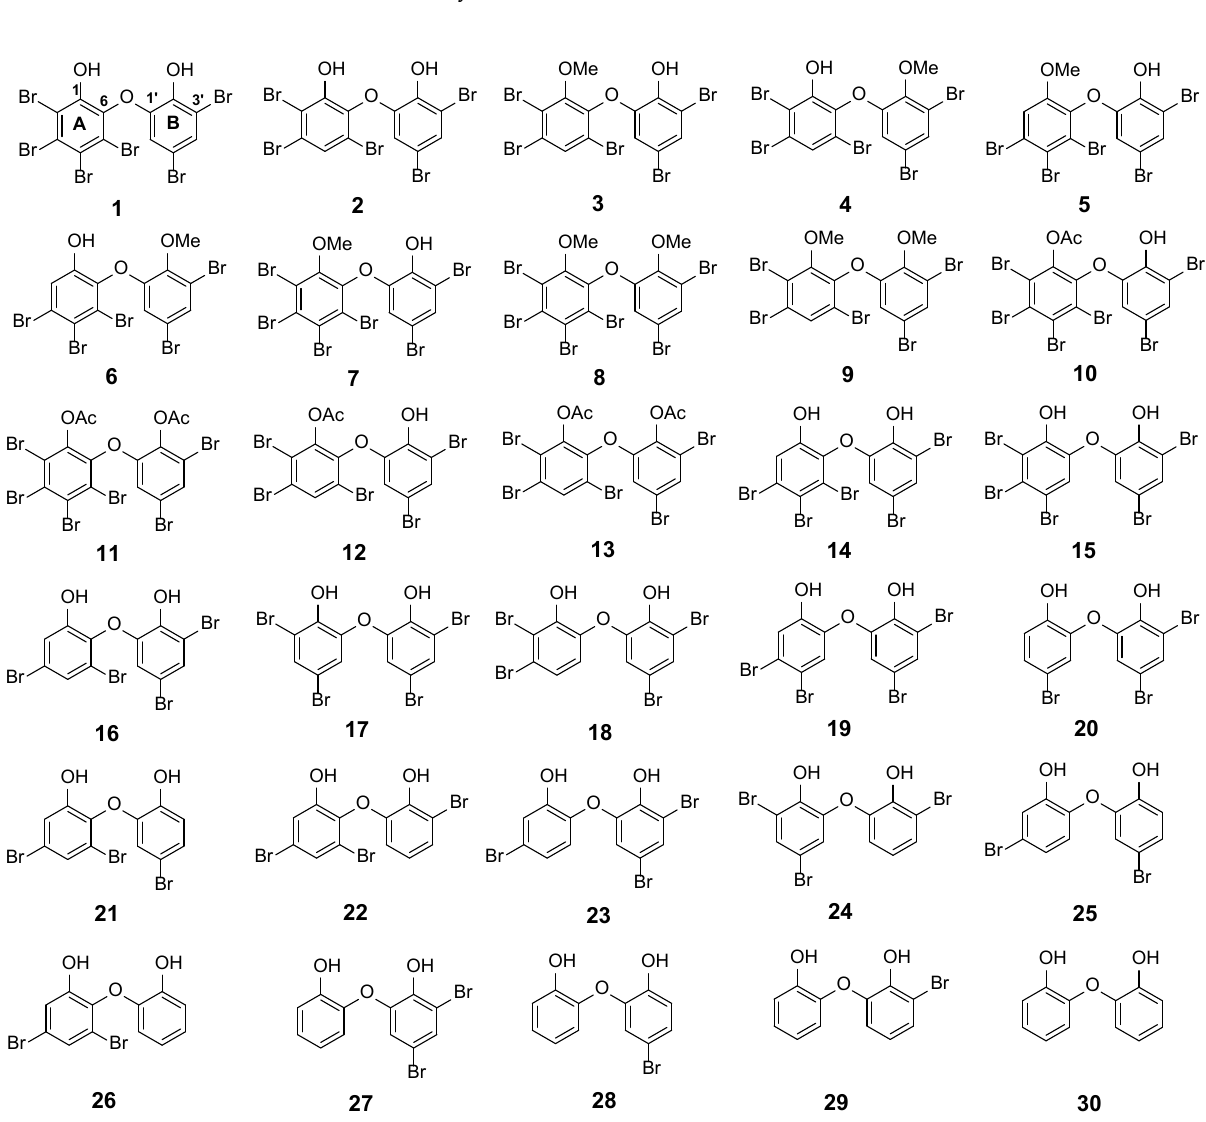
Figure 1. PBDE structures ( 1 – 6 ) from Lamellodysidea herbacea isolated in the present work via methylation ( 7 – 9 ), acetylation ( 10 – 13 ), and debromination ( 1 , 2 , 14 , 16 – 18 , 20 , 23 , 26 ). Compound 30 was commercially available.